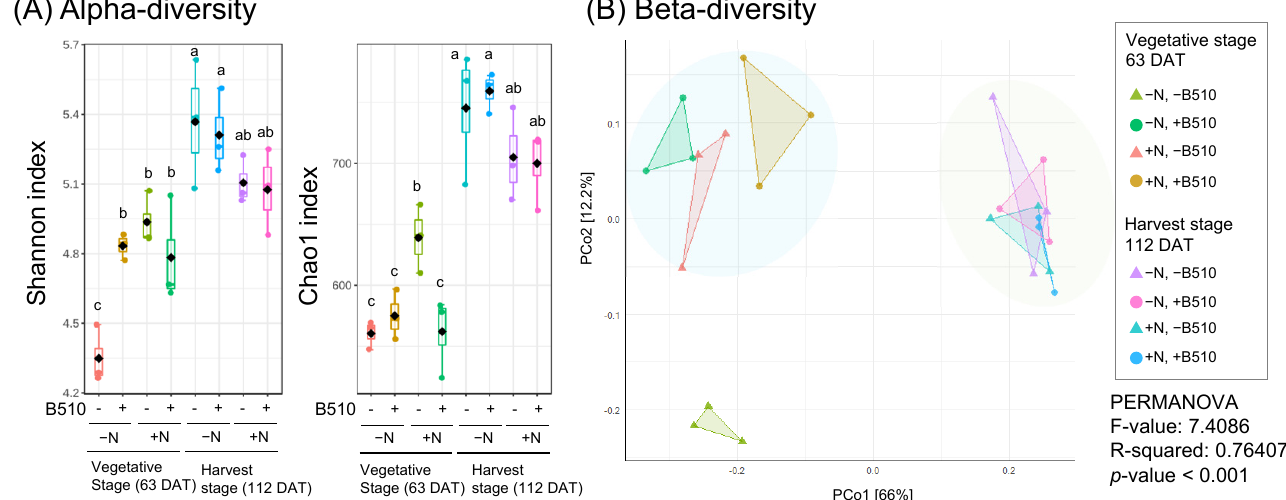
Figure 1. Influence of B510 on root-colonized microbiota with different levels of N-fertilizer and two stages of plant development. Measurement of the alpha-diversity ( A ) and beta-diversity ( B ) of the rice root-colonized bacteria. Rice plants inoculated with B510 (+) and without B510 ( − ), and fertilized with chemical nitrogen (+N) and non-fertilized ( − N) harvested at the vegetative stage (63 DAT) and the harvest stage (112 DAT). ( A ) Shannon index and Chao1 index were used in the analysis of the alpha diversity. All values are means of three replicates ± standard errors. Statistical analysis was performed, different letters indicate significant difference between treatments (Student-Newman-Keuls [SNK] test, P <0.05, n=3). (B) Principal Coordinate Analysis (PCoA) are plotted based on Bray-Curtis distance metrices for taxonomical data ( p < 0.01). Permutational multivariate analysis of variance (PERMANOVA) was performed.